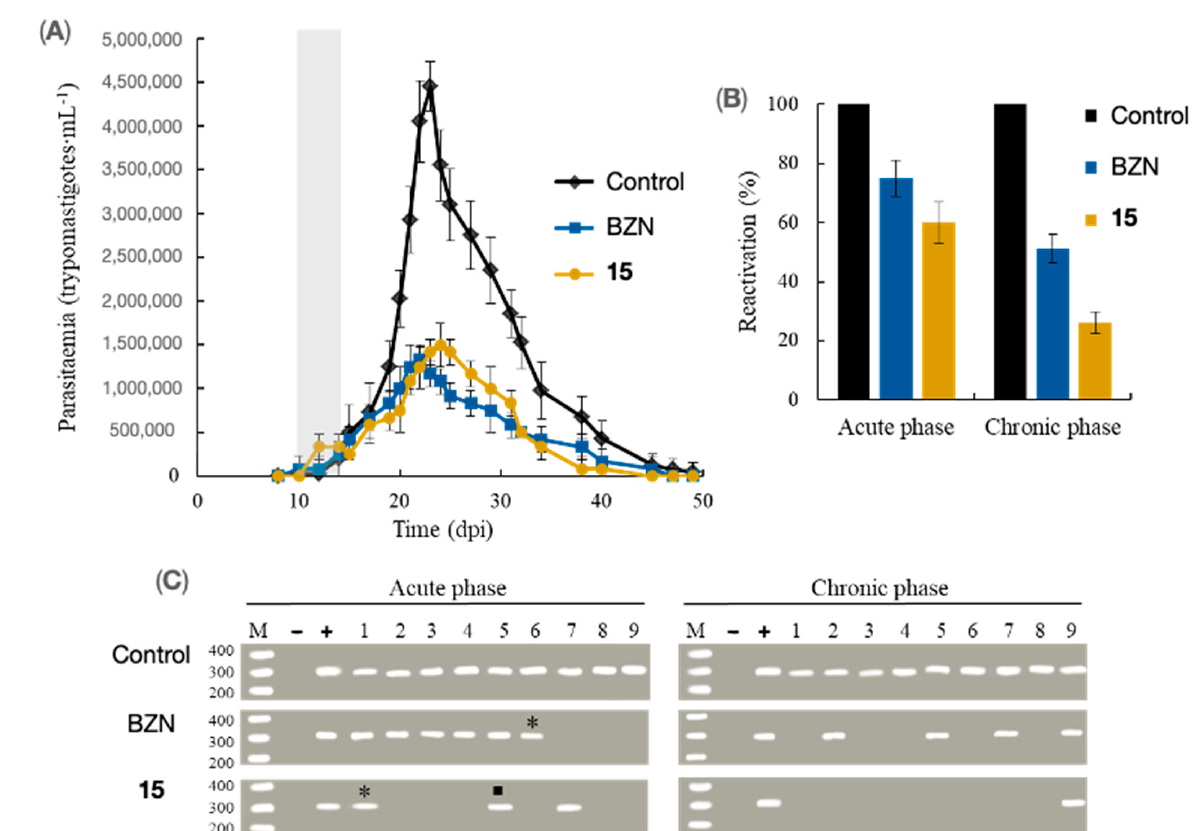
Figure 2. ( A ) Parasitaemia profile of untreated and treated mice during the acute infection. Treatment time is represented in grey. Values are the mean of three mice ± standard deviation. Significant differences between untreated and treated mice ( p < 0.05). ( B ) Reactivation of parasitaemia after immunosuppression of mice during the chronic infection. Values are the mean of three mice ± standard deviation. Significant differences between untreated and treated mice ( p < 0.05). ( C ) PCR analysis of the nine target organs/tissues after treatment of mice during the acute and chronic infection. Lanes: M, base pair marker; − , PCR negative control; +, PCR positive control; 1, adipose; 2, bone marrow; 3, brain; 4, oesophagus; 5, heart; 6, lung; 7, muscle; 8, spleen; 9, stomach. * 1/3 of the mice showed PCR product on electrophoresis; ■ 2/3 of the mice showed PCR product on electrophoresis. BZN, benznidazole.